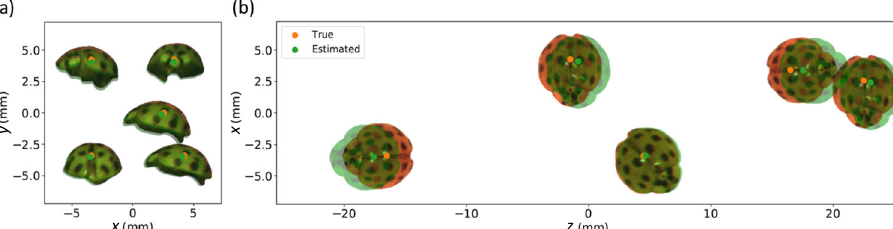
Fig. 4 3D extended-object tracking and its orientation estimation using focal stack data collected by a CMOS camera. ( a ) Results in the x - y -plane perspective and ( b ) in the x - z -plane perspective. The estimated (true) ladybug ’ s position and orientation are indicated by green (orange) dots and green (orange) overlaid ladybug images. Note that the ladybug images are not a part of the neural network output and are shown for illustration